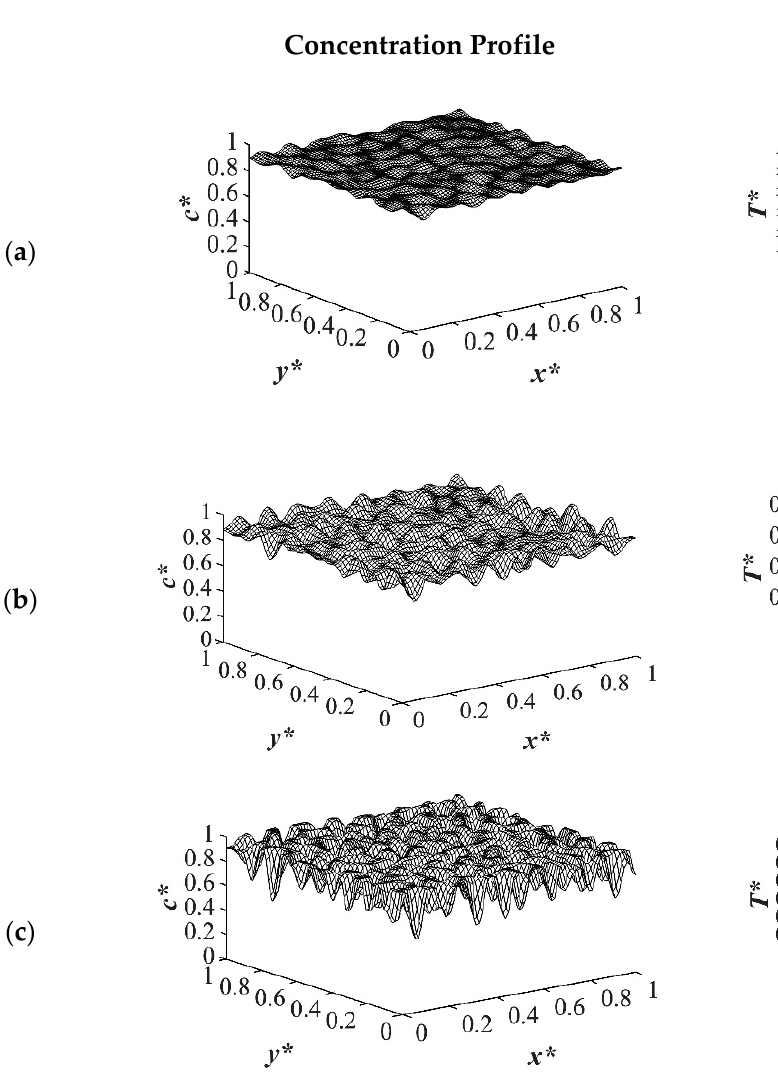
Figure 9. Spatial concentration ( left column) and temperature ( right column) profiles for the off- critical quench to c * = 0.909 at t * = 8.01 × 10 − 4 for three different quench depths of ( a ) T * q1 = 1.0, ( b ) T * q2 = 0.99 ( c ) T * q3 = 0.97.